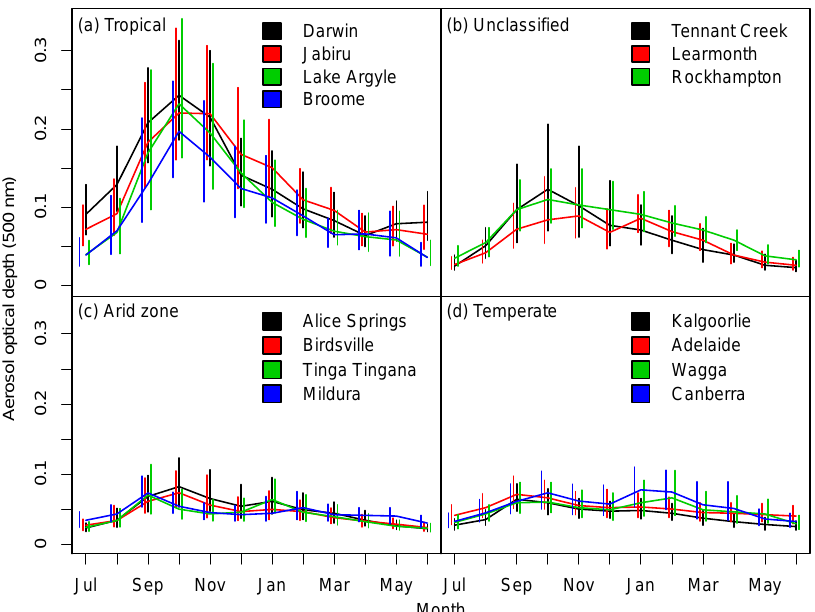
Figure 10. The monthly climatology of aerosol optical depth at 500nm, for (a) tropical, (b) unclassified, (c) arid zone, and (d) temperate regions. The plots depict the monthly median, with the vertical bars showing the interquartile range, i.e. the range in aerosol optical depth between the 25th and 75th percentiles. The vertical bars are offset between sites for clarity.